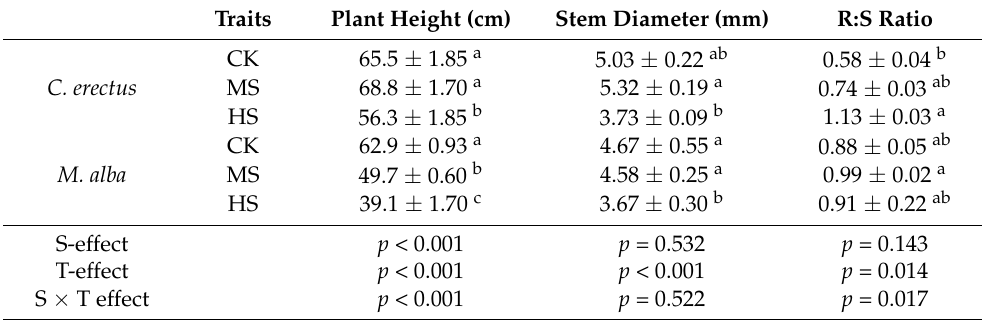
Table 1. Effect of water deficit on various growth attributes like plant height, stem diameter and root: shoot ratio (R:S ratio) in C. erectus and M. alba . The traits were tested using a two-way ANOVA for species effect (S-effect), treatment (T-effect) and interaction (S × T) effects. Values represent the means ( ± SE) in various treatments. Small letters represent significant differences within each species tested using Dunnett’s test. Test were taken to be significant at p <